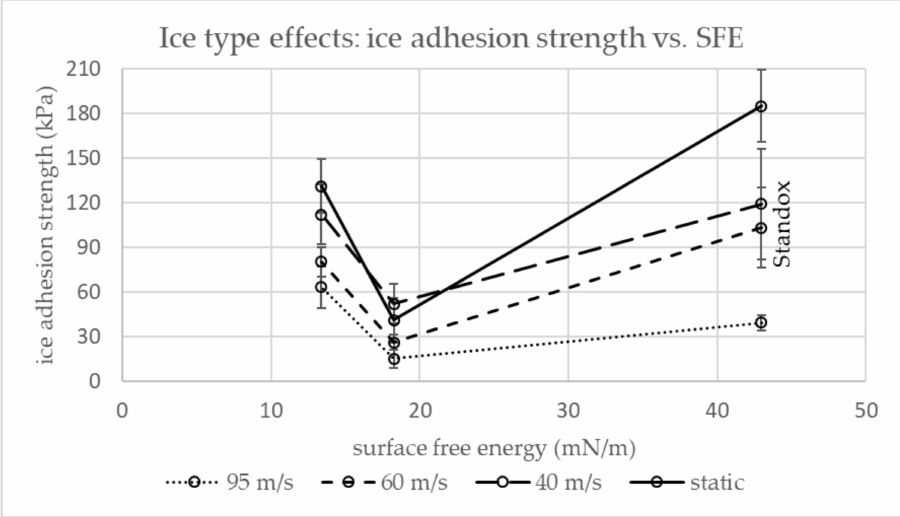
Figure 9. Surface free energy (SFE) and ice adhesion strength data for different ice formation types. The lowest SFE of the PTFE-tape (SFE = 15.1 mN/m) in this study did not result in the lowest ice adhesion strength (as presented before). PUR C25 (SFE = 18.0 mN/m)